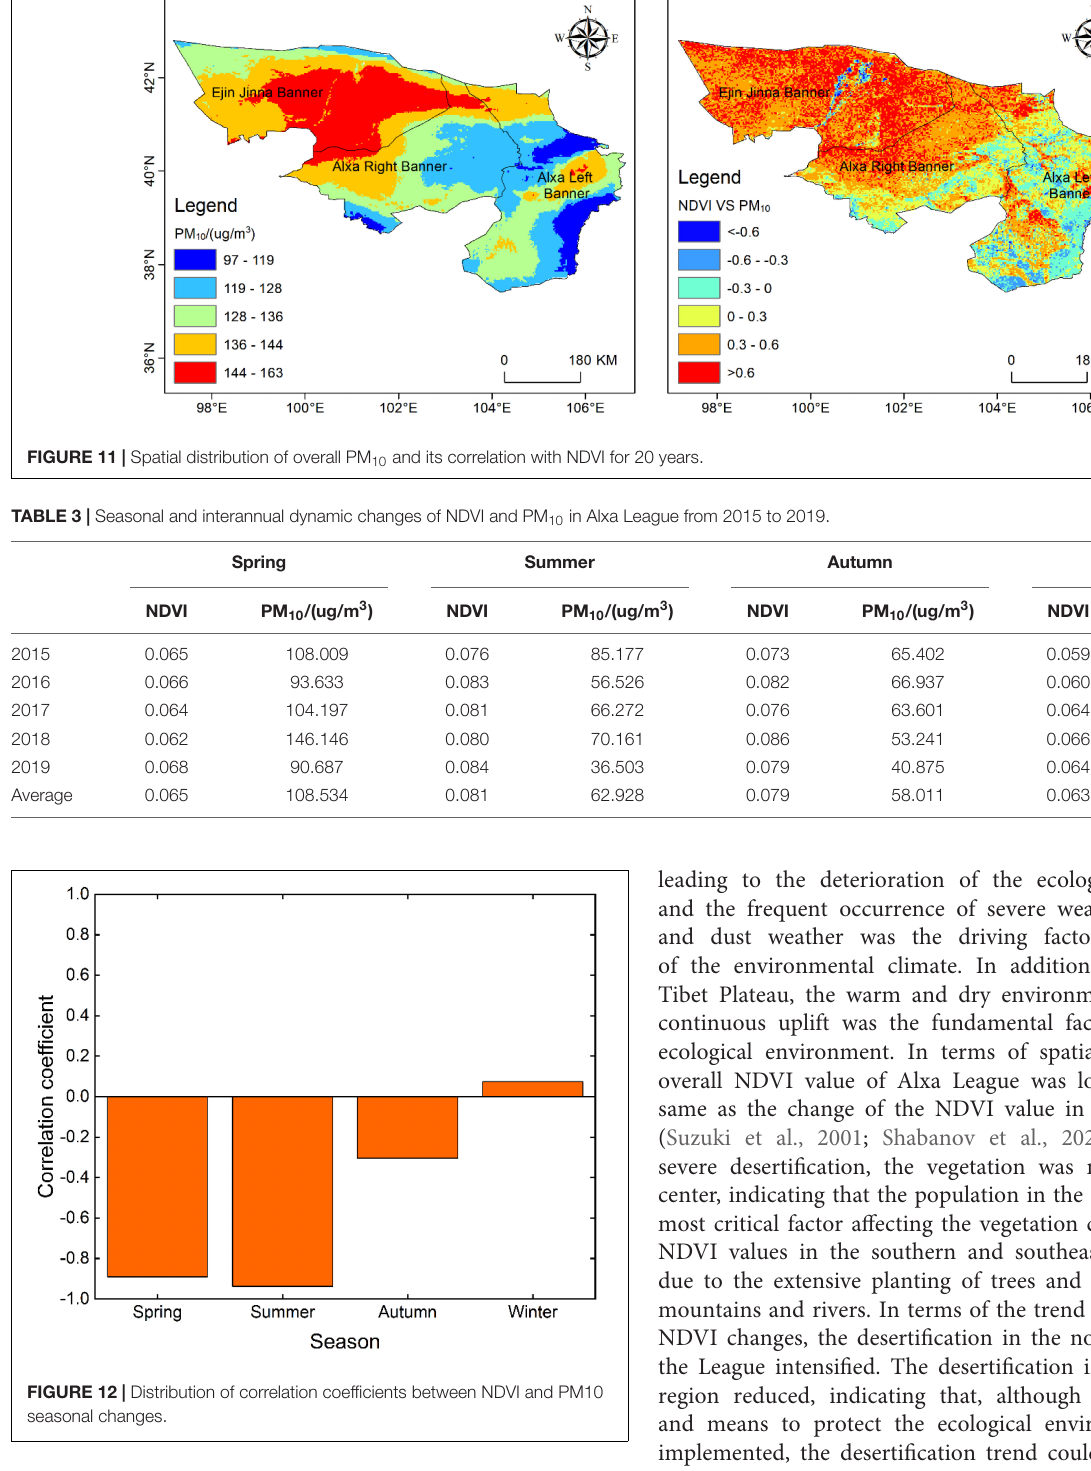
(Xie et al., 2021). After 2012, the desertification situation of Alxa League worsened. Zhang and Huisingh (2018) and others found that warm and dry climates were the critical